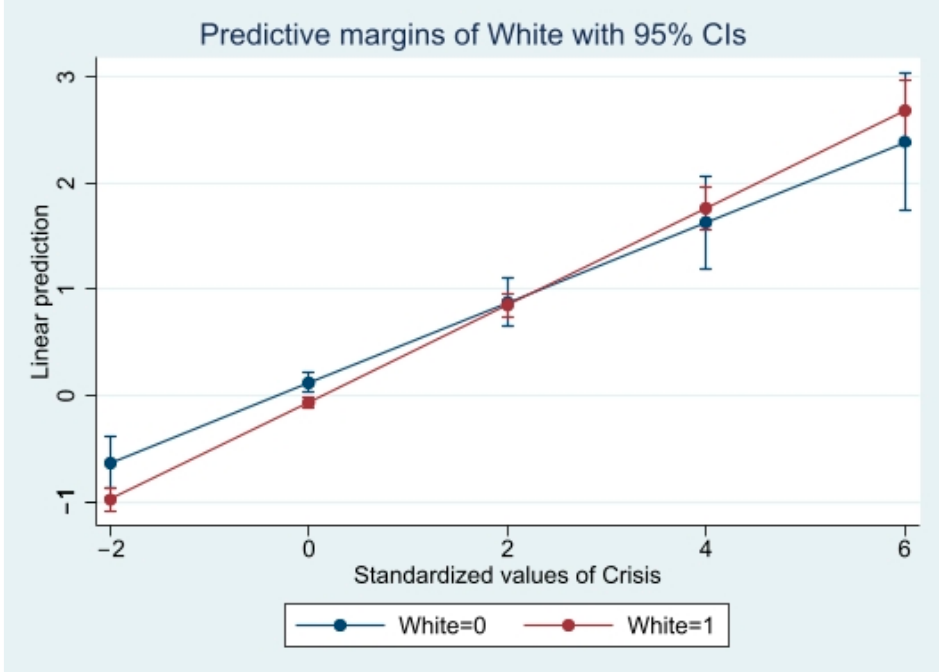
Figure 2. Predicted Coronavirus Anxiety by Crisis Perception and Race.